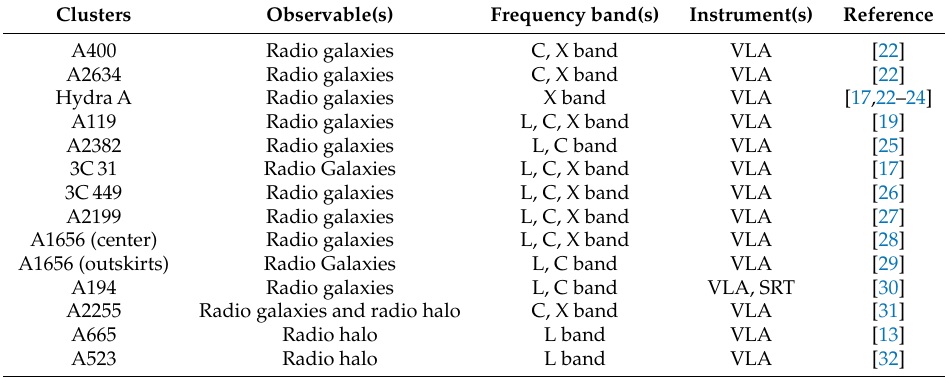
Table 1. Summary of all the clusters for which either a numerical or analytic study of the intracluster magnetic field is